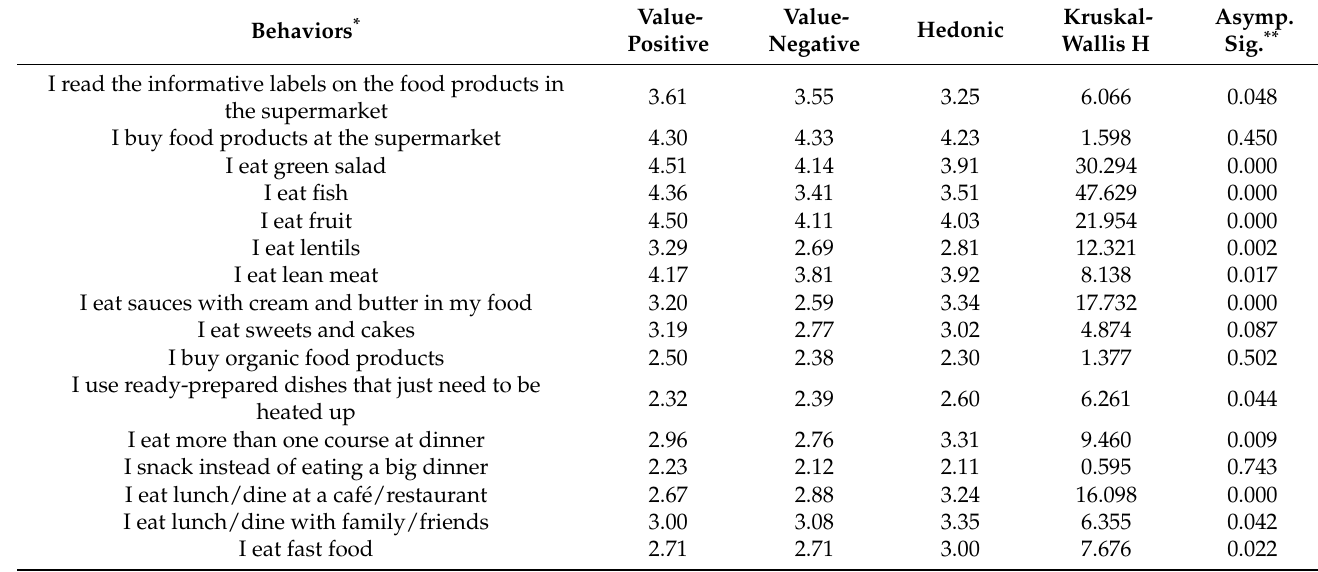
Table 12. Food-related behaviors by consumer